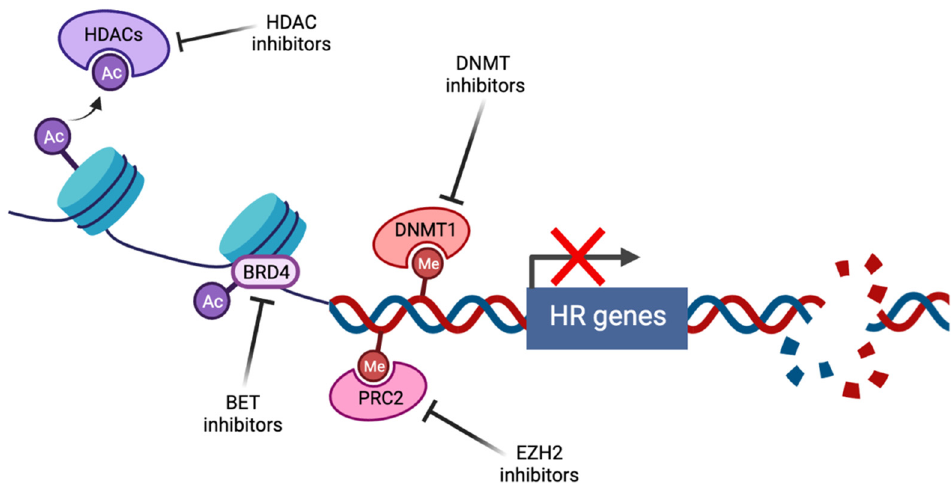
Figure 1. Induction of BRCAness by pharmacological targeting of epigenetic pathways (created with Biorender.com, accessed 15 May 2022). Histone deacetylase inhibitors (HDACi) prevent the histone deacetylation activity of HDACs, thus maintaining chromatin in a condensed state associated with transcriptional repression. Bromodomain and extraterminal (BET) family members such as BRD4 act as transcriptional cofactors at acetylated gene promoters, including the homologous recombination (HR) genes RAD51 and BRCA1 , whose expression is suppressed by BET inhibition. DNA methyltransferase (DNMT) and enhancer of zeste homolog 2 (EZH2) inhibitors alter genome-wide methylation patterns and have been linked to altered DNA double strand break repair gene expression. In each case, repression of HR gene expression and activity has been described, contributing to induction of the BRCAness